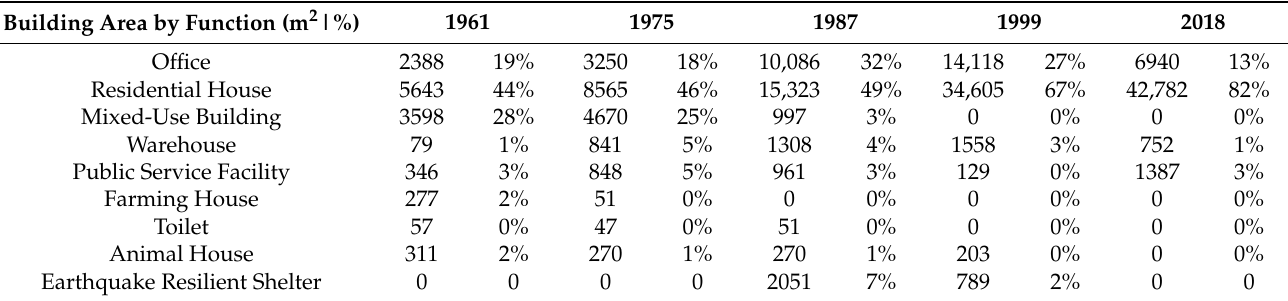
Table 6. Building area and proportion by